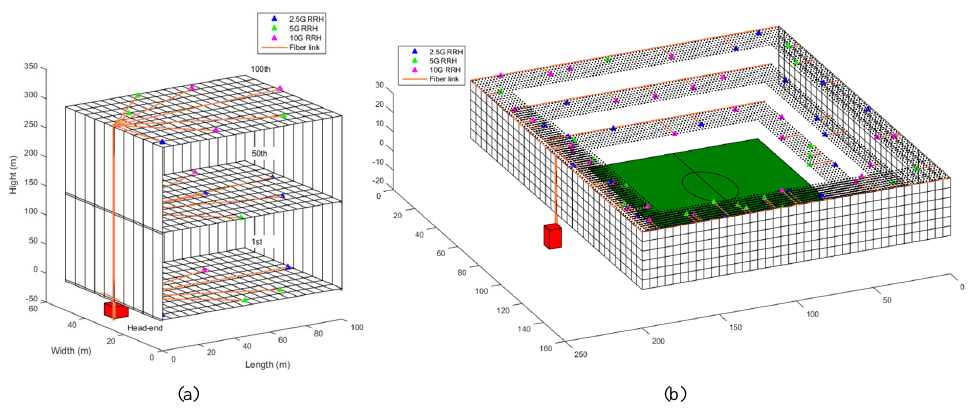
Figure 3. Deployment scenarios of the proposed 5GB neutral host architecture. ( a ) One-hundred-story commercial building. ( b ) Stadium.